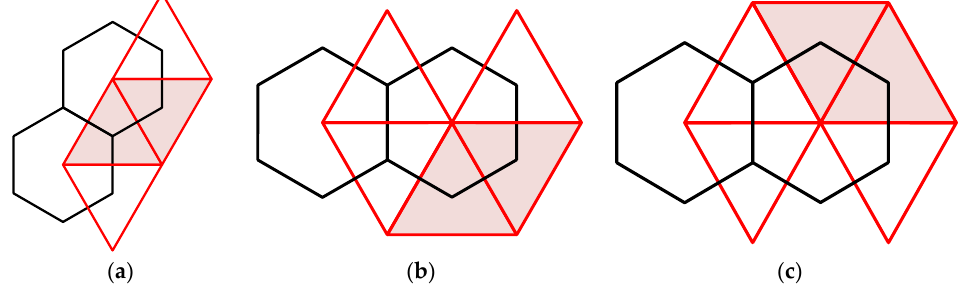
Figure 9. Triangle selection rules of HtoTcode for spatial discrete line and surface data. ( a ) Edge adjacency; ( b ) Corner adjacency and the ( n − 1)th triangle is a lower triangle; and ( c ) Corner adja- cency and the ( n − 1)th triangle is an upper triangle. Figure 8. Icosahedral hexagonal cell type.